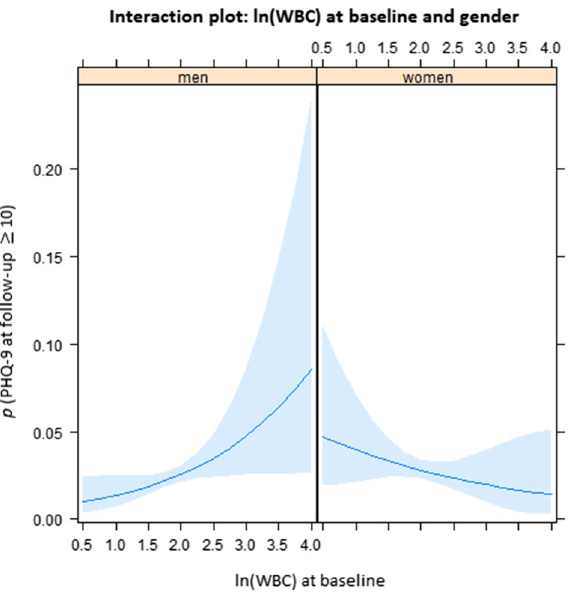
Figure 3. Interaction plot between gender and natural log of white blood cell count as predictors of new onset of depression 5 years later. There were differences between men and women with respect to the association of elevated levels of WBC at baseline with new onset of depression at follow-up: in men, elevated WBC at baseline was more closely associated with higher PHQ-9 sum scores at follow-up. The plot results show the probability ( p ) and 95%-confidence intervals (shaded areas) of depression (PHQ-9), estimated based on the regression model of the total sample (reported in Table 4), depending on baseline natural log of WBC and other predictors held fixed. (Figures were created using R version 3.6.1 https ://www.R-proje ct.org/).